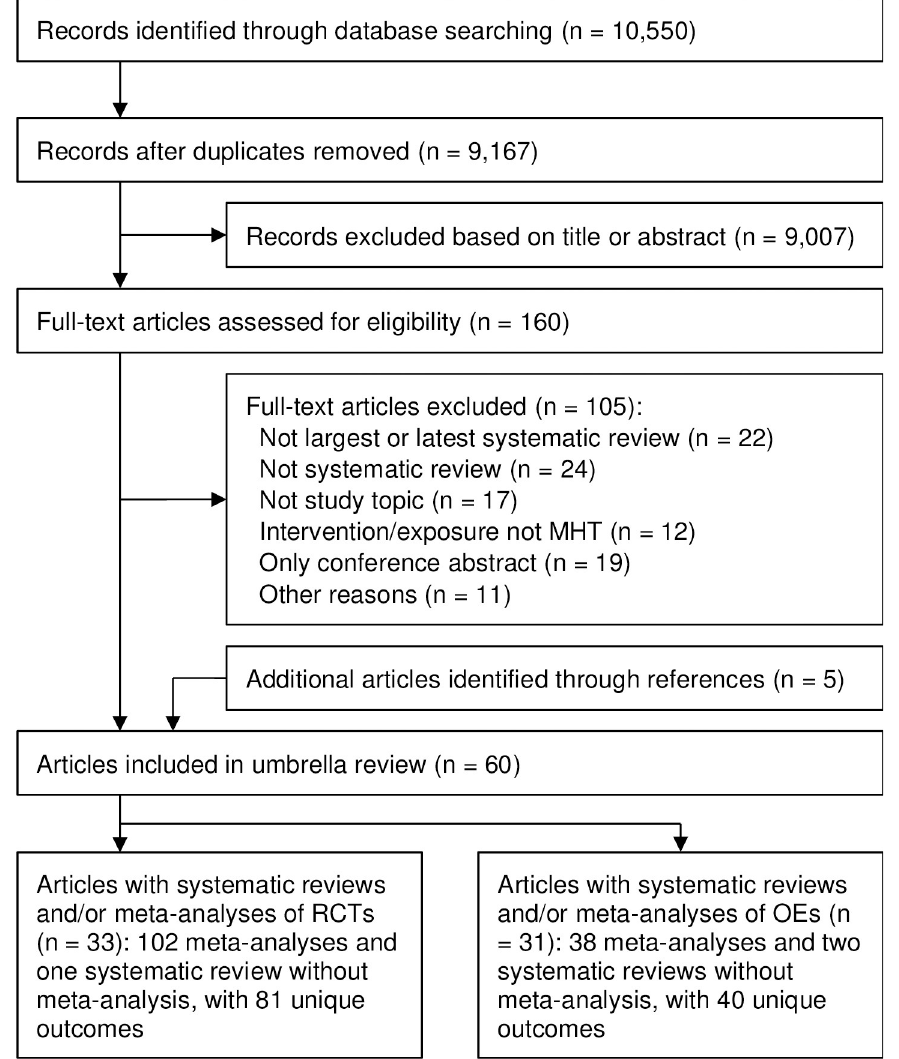
Fig 1. Flow chart for study selection process. MHT, menopausal hormone therapy; OE, observational epidemiological study; RCT, randomized controlled trial.